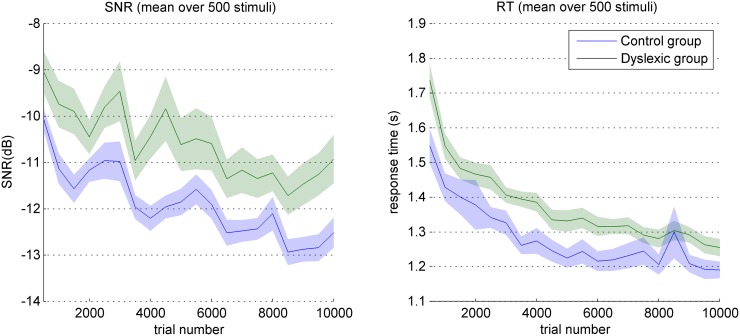
Evolution of performances over the course of the experiment.Mean SNR (left) and mean RT (right) by sessions of 500 trials, for the two groups. Shaded regions denote s.e.m. over participants.